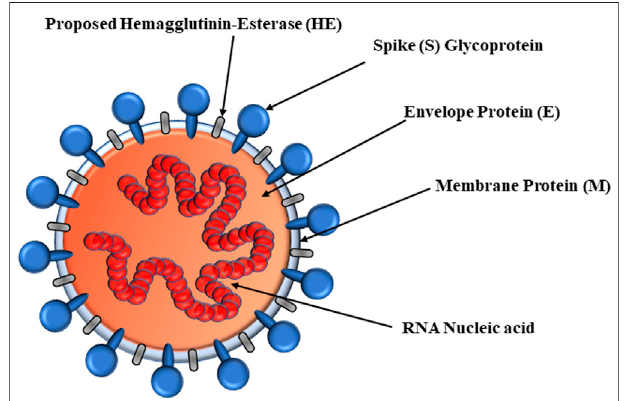
FIGURE 1 | Structure of enveloped coronavirus